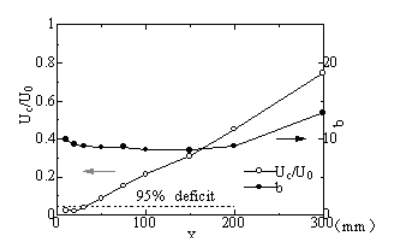
Fig. 7 Distribution of mean velocity (14Hz forcing).